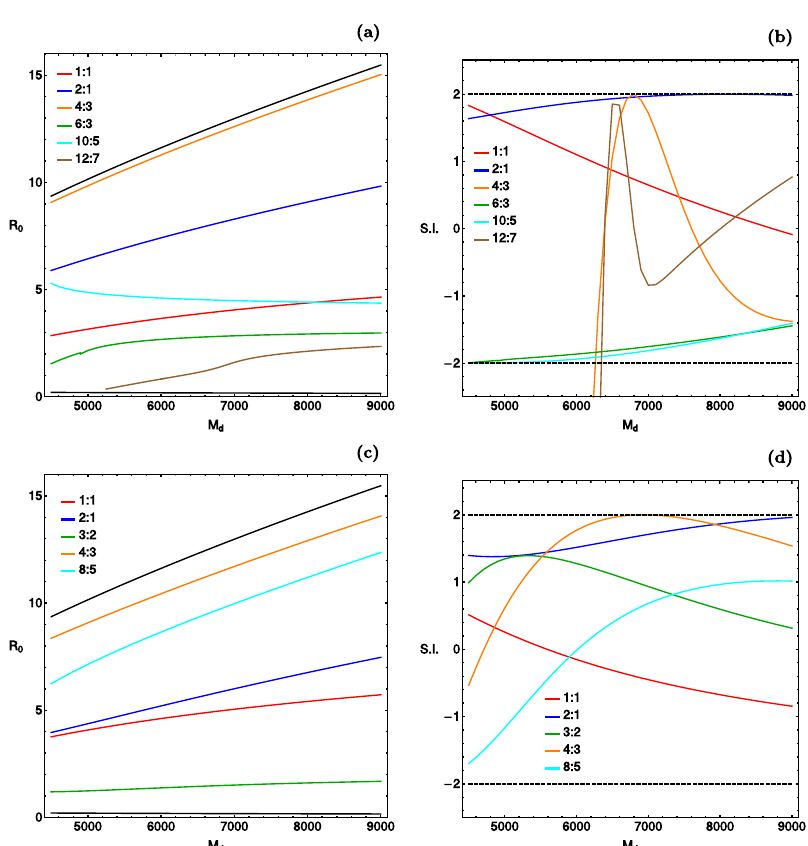
Fig. 3. Evolution of the R coordinate of periodic orbits as a function of the mass of the disk, M d , for the PH models (panel a) and OH models (panel c), and the evolution of the stability index S.I. as a function of M d for the PH models (panel b) and OH models (panel